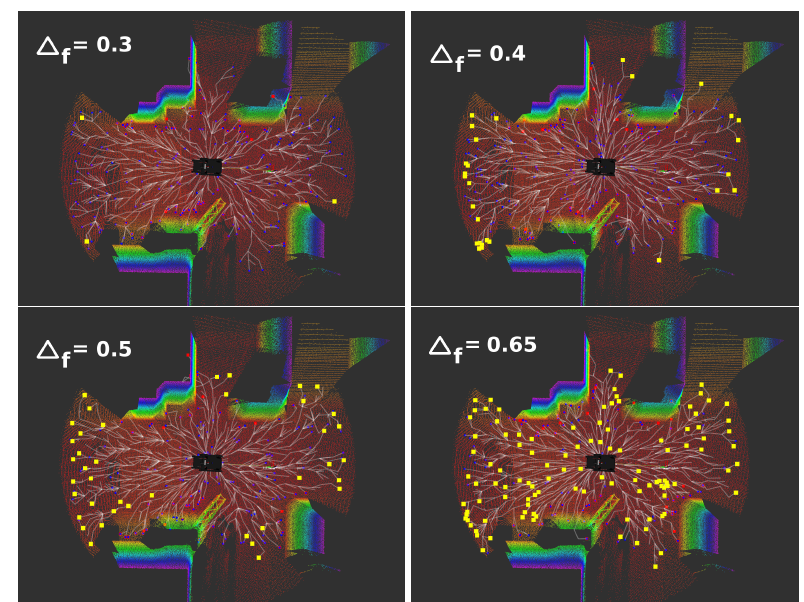
Figure 10. Frontiers detected (yellow squares) according to different values of frontier threshold ∆ f .